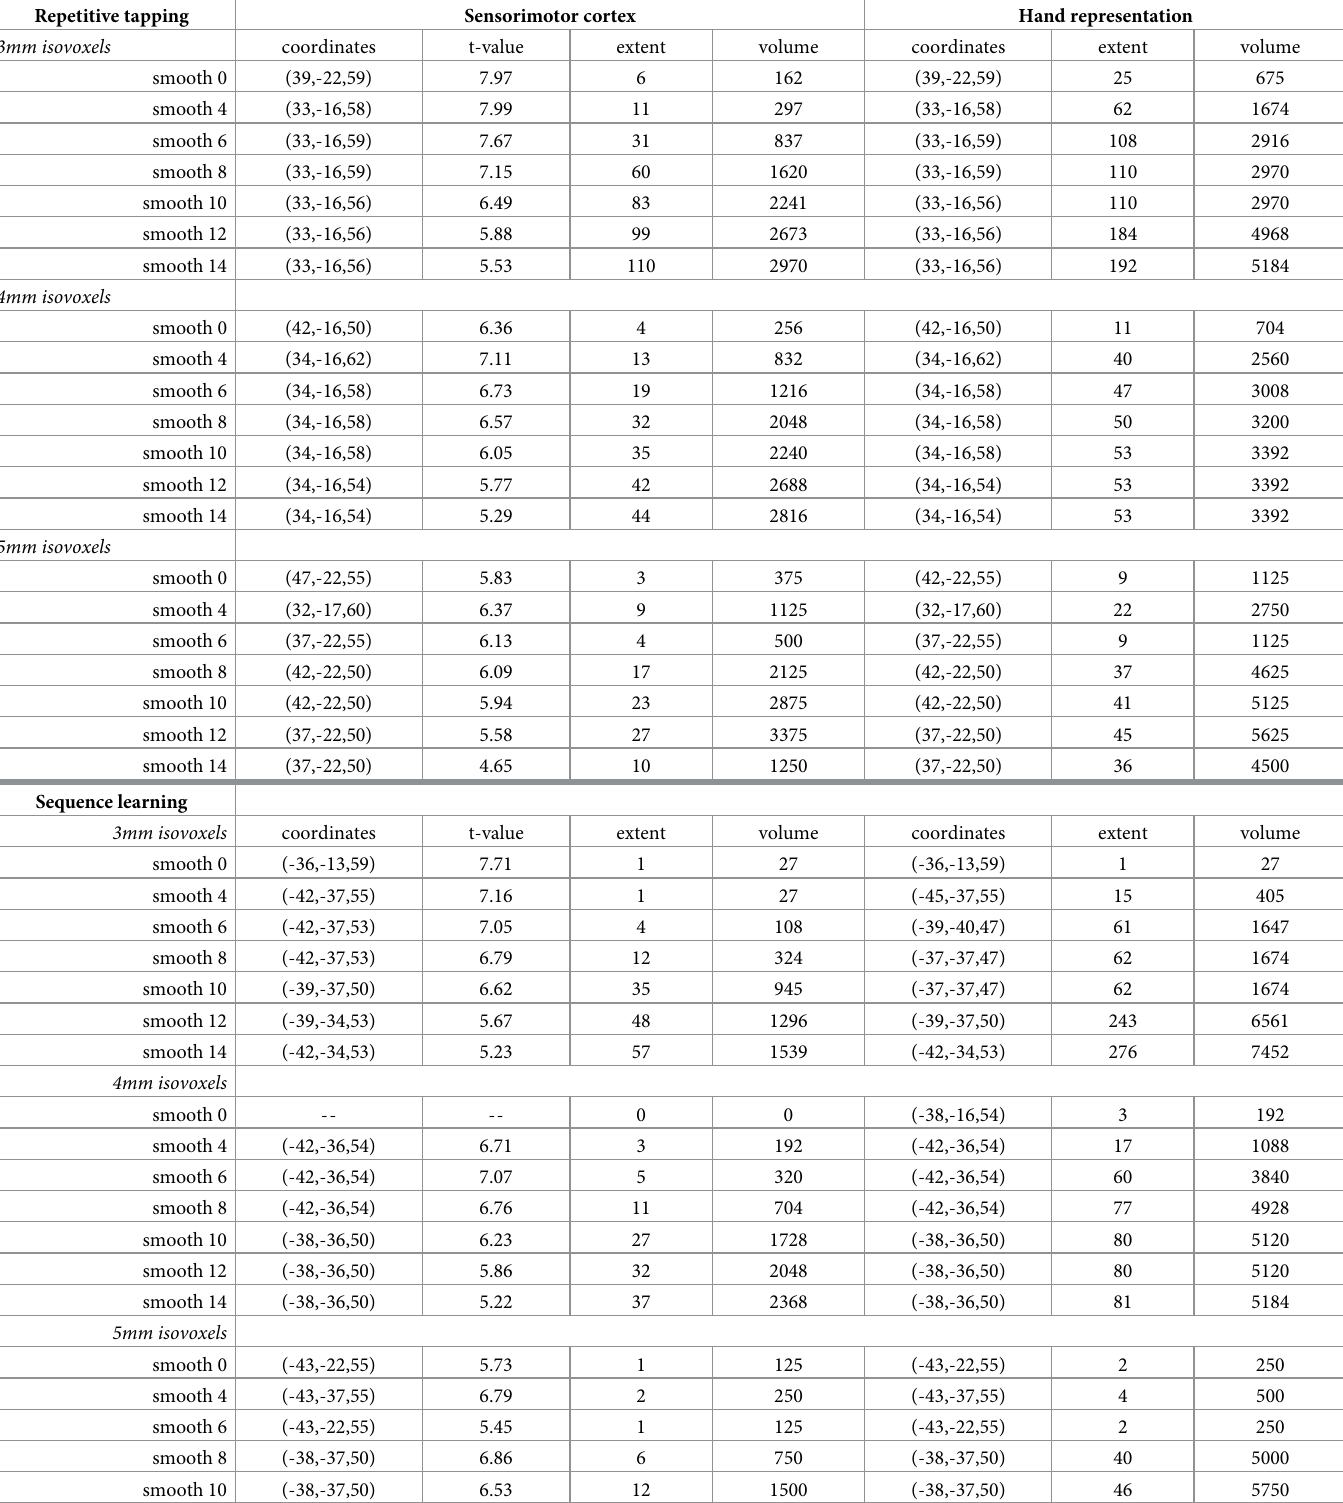
Table 1. Effect of voxel size and smoothing kernel on sensorimotor cortical activation from random effects group analysis during motor tasks. Repetitive